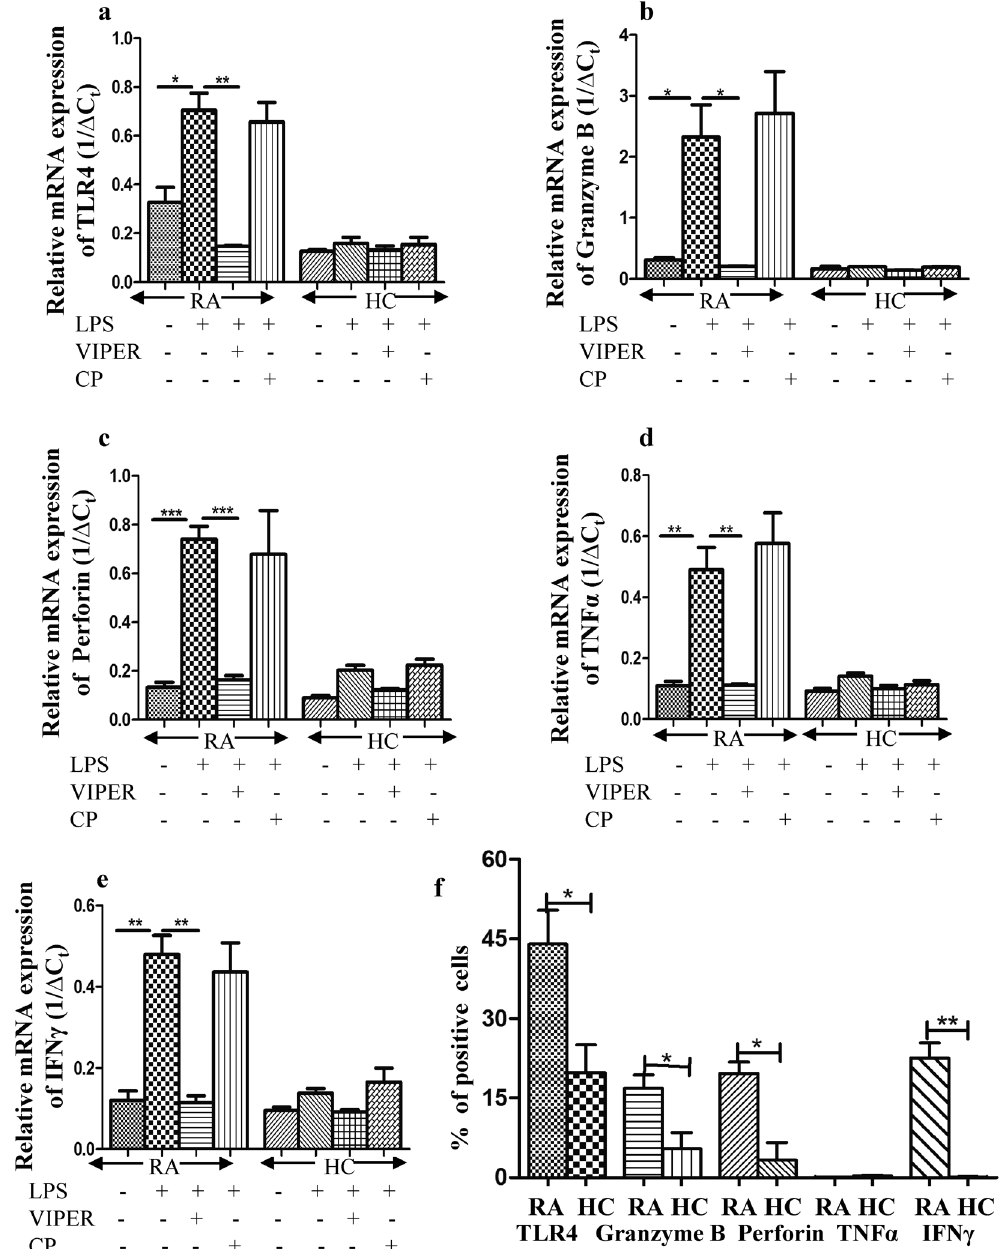
Figure 4. LPS triggers TLR4 dependent activation of CD8 + T cells isolated from RA patients augmenting cytotoxic and inflammatory lymphocyte responses. CD8 + T cells isolated from RA (n = 6) and HC (n = 6) blood samples were pre-stimulated with 5 µ M of VIPER and 5 µ M CP7 for 2 hours and then treated with 5 µ g/ml LPS for 6 hours. These cells were then evaluated for relative mRNA expression with respect to β -actin for TLR4 ( a ), Granzyme B ( b ), Perforin ( c ), TNF α ( d ) and IFN γ ( e ). Pre-stimulation of VIPER significantly inhibited the expression of all mediators while the inert peptide CP7 had no effect. ( f ) The graph shows percent CD8 + T cells expressing TLR4, Granzyme B, Perforin, TNF α and IFN γ proteins in the experimental set up. Bars represent the mean ± SEM. * p < 0.05, ** p < 0.01, *** p <